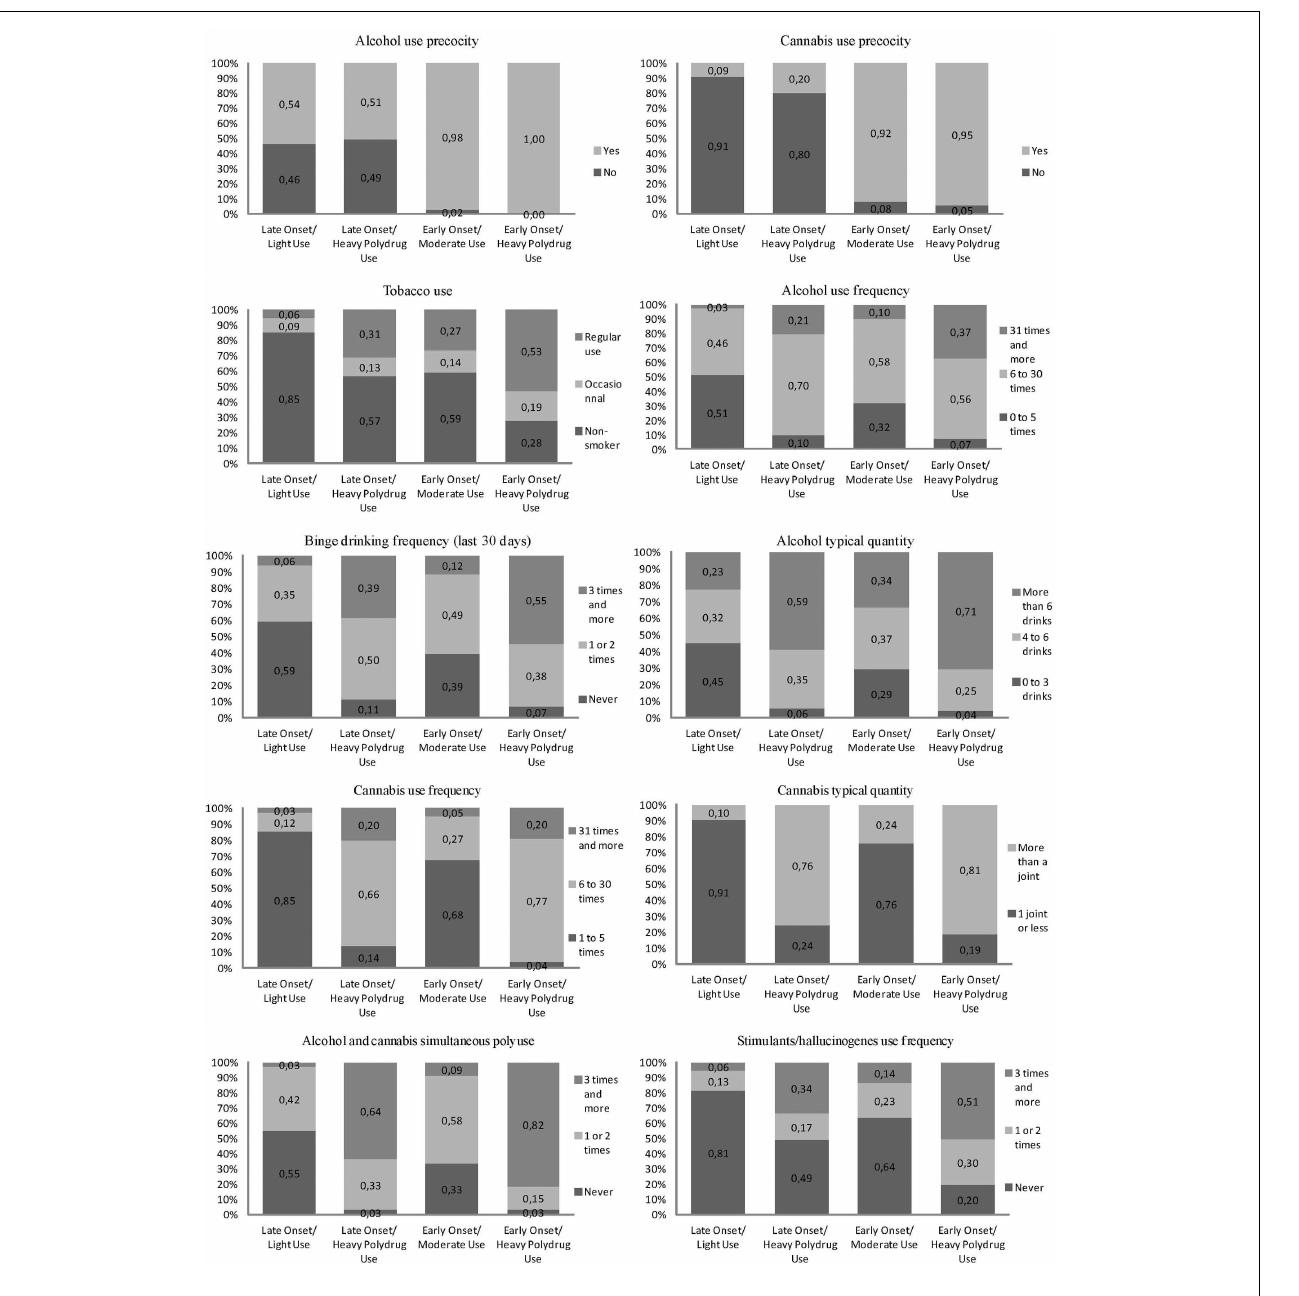
FIGURE 1 | Substance use items’ category frequencies by classes